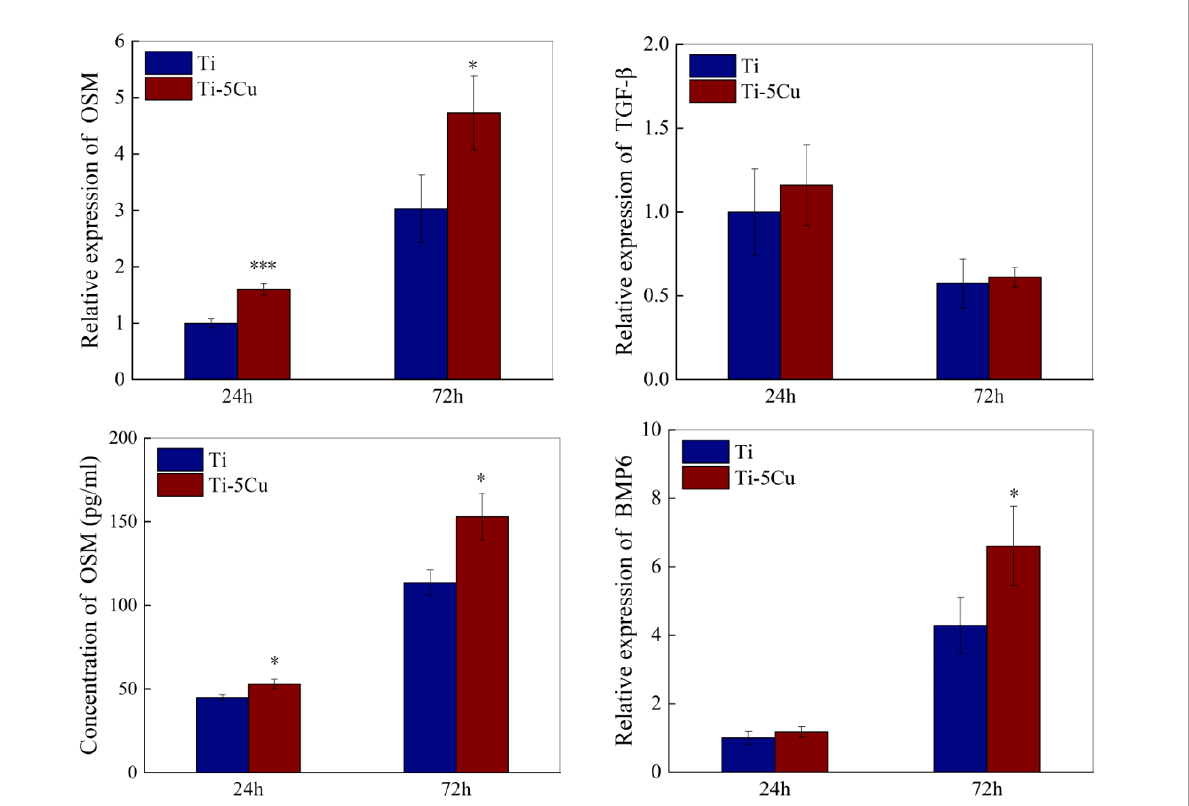
FIGURE 6 The gene and protein expressions of osteogenic cytokines in RAW264.7 cells after co-cultured with Ti and Ti-5Cu alloy at 24 and 72 h by RT- qPCR and ELISA (n = 3; *p < 0.05, ***p < 0.001).